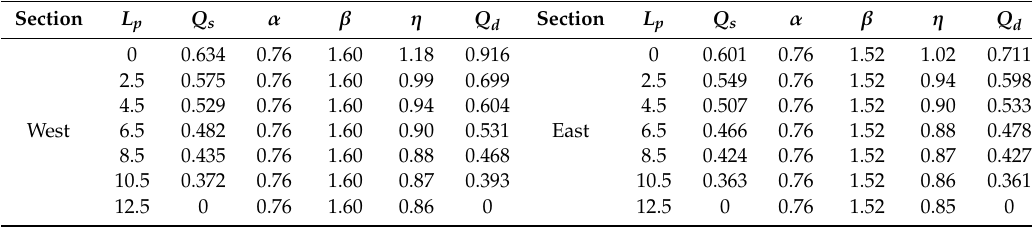
Table 3. Normalized seepage field distortion